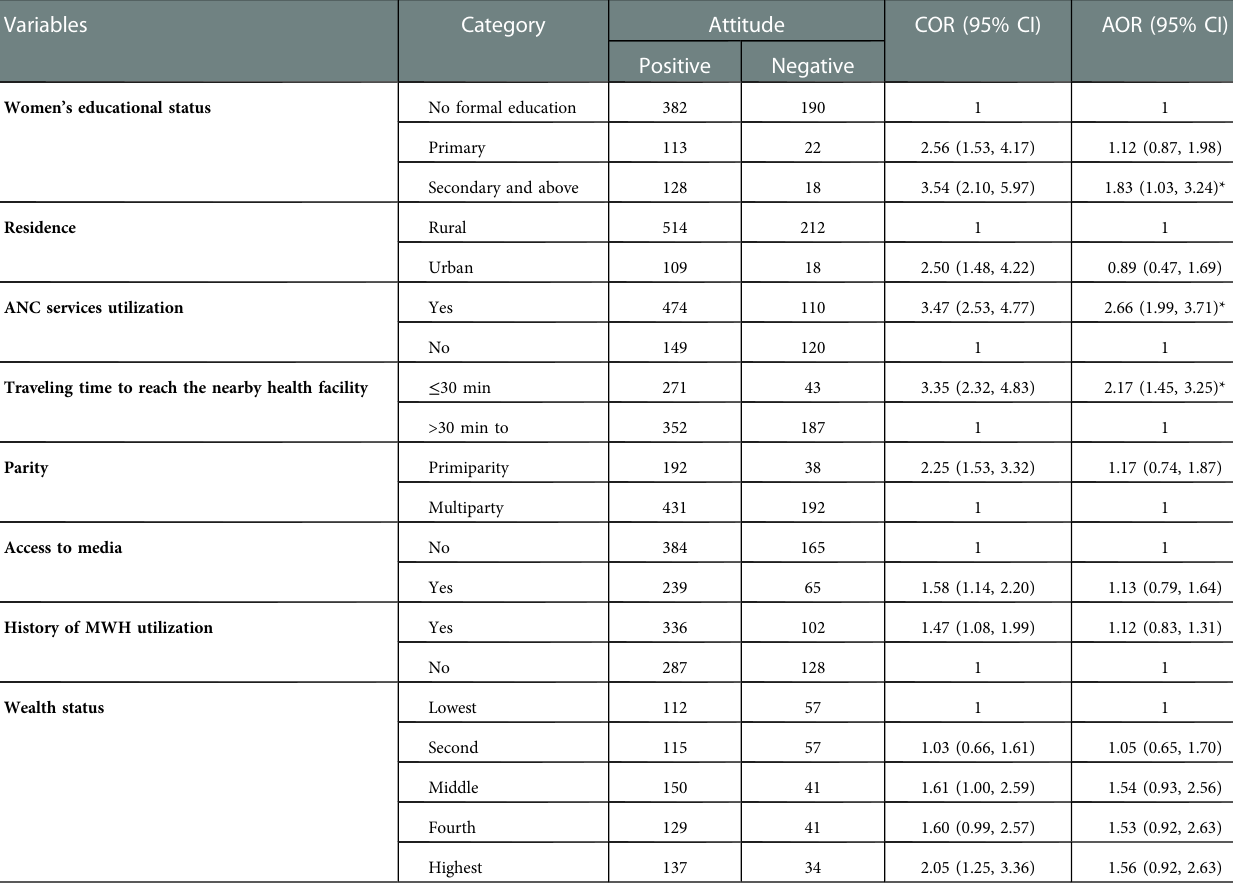
TABLE 6 Multivariable logistic regression analysis on factors associated with women attitude towards MWH services in dega damot district, northwest Ethiopia, 2021.